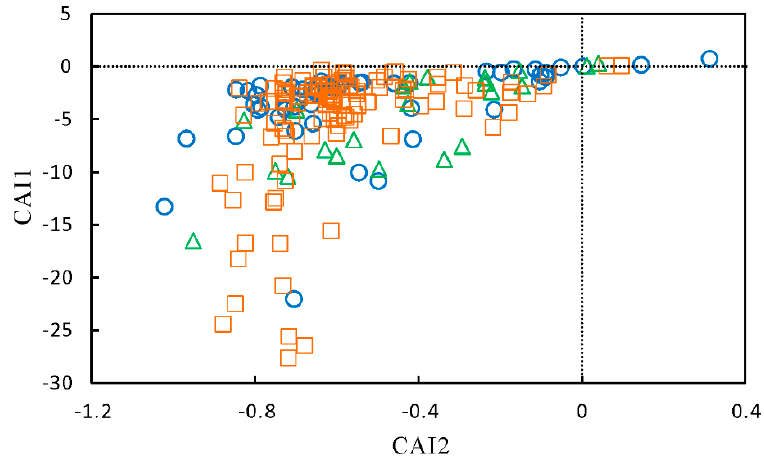
Figure 9. Scatter plot of CAI1 versus CAI2 for the groundwater samples in the study area.